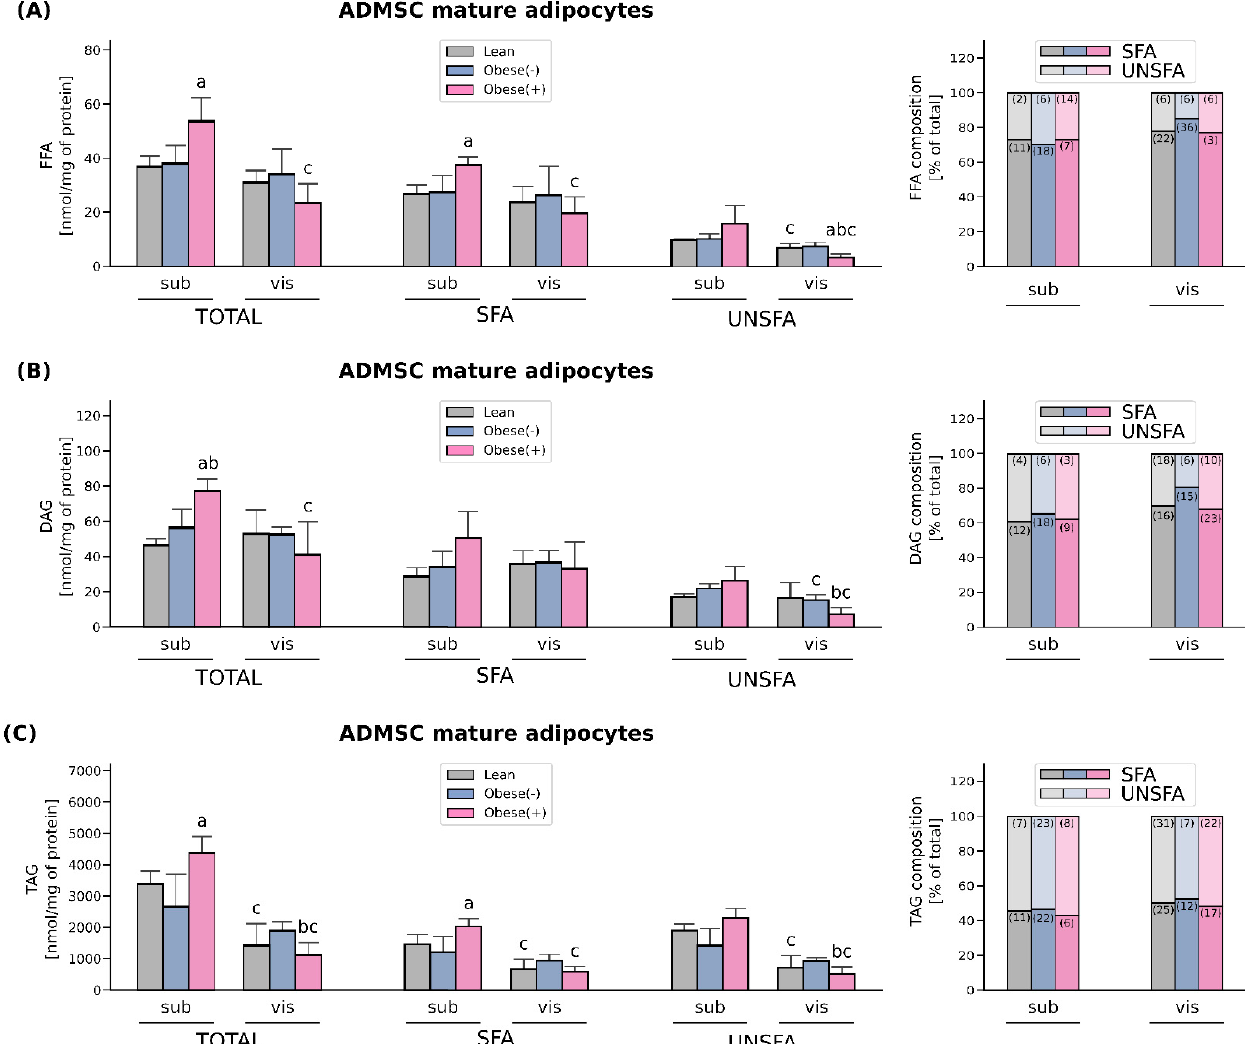
Figure 6. Lipid content and FA-profile in differentiated adipocytes derived from subADMSCs and visADMSCs of lean and morbidly obese women. The amount of total saturated fatty acid species (SFA), unsaturated fatty acid species (UNSFA) and FA distribution in ( A ) FFA, ( B ) DAG, ( C ) TAG. Values are expressed in nmol per mg of protein. a–difference vs. Lean group in the studied tissue; b–difference vs. Obese(-) group in the studied tissue; c–difference between adipocytes differentiated from visADMSCs vs. subADMSCs within the patient metabolic status. Bars and whiskers represent the mean and SD ( n = 4 for each study group, measurements taken in triplicate). For the percentage fatty acid composition, numbers in brackets inside bars represent SD. p < 0.05. Designation of the